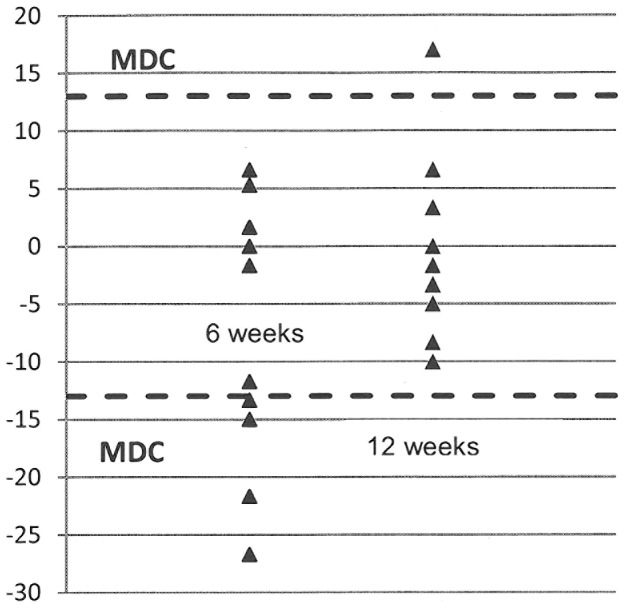
Individual change scores from baseline for MSWS at 6 and 12 weeks.Broken line: Levels of Minimally Detectable Change (MDC) for negative change (indicates improvement) and positive change (indicates deterioration).